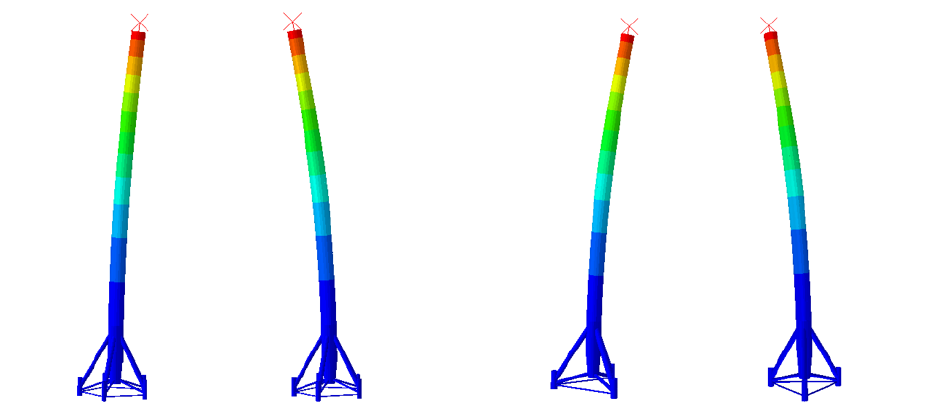
Figure 15. Design ranges for the fundamental frequency of 5.5 MW capacity turbine.